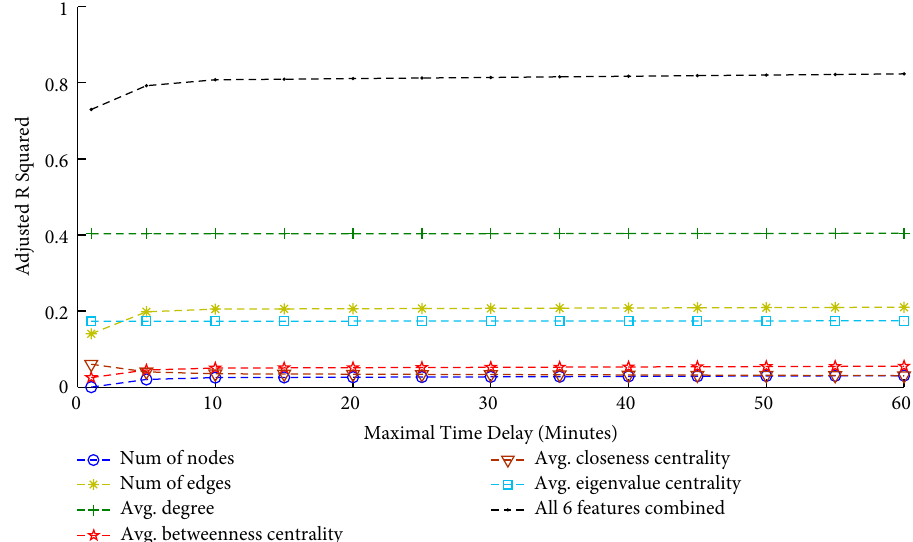
Figure 10: Adjusted 𝑅 2 of the correlation between seven features of the hourly rides network and the potential ride-sharing utilization for this network. Most features have low quality of fit, but the combined mixture of all seven results in a remarkably high correlation ( 𝑅 2 = 0.82 ). Features are (1) the number of nodes in the network, (2) the number of edges, (3) the averaged degree, (4) the averaged betweenness centrality, (5) the averaged closeness centrality, and (6) the averaged eigenvector